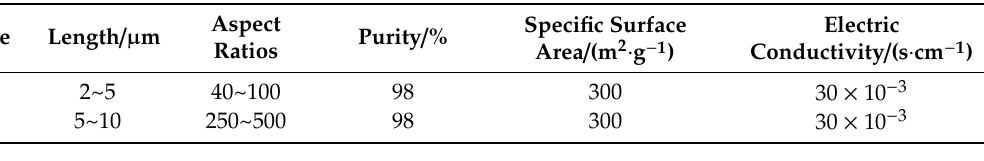
Table 2. Properties of multi-walled carbon nanotubes.